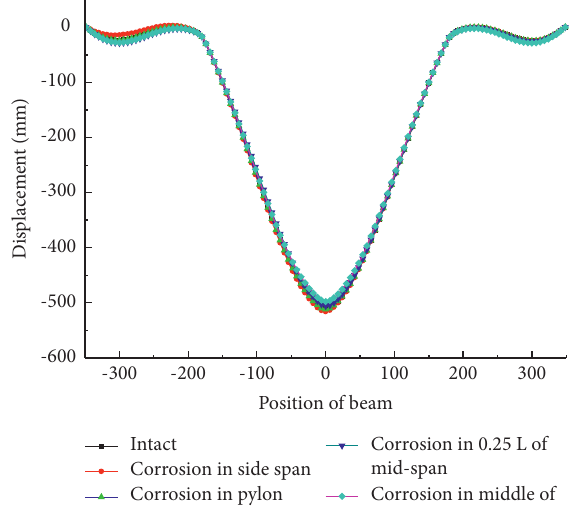
Figure 16: Vertical displacement in the corroded truss girder scenario.